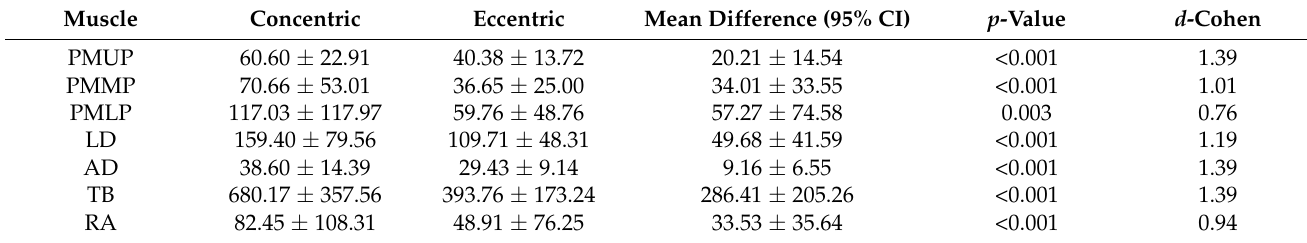
Table 4. Comparison of EMG activity (expressed in µV) during the concentric and eccentric phases in the straight arm pulldown exercise at 150% biacromial width. Mean ± standard deviation (SD).